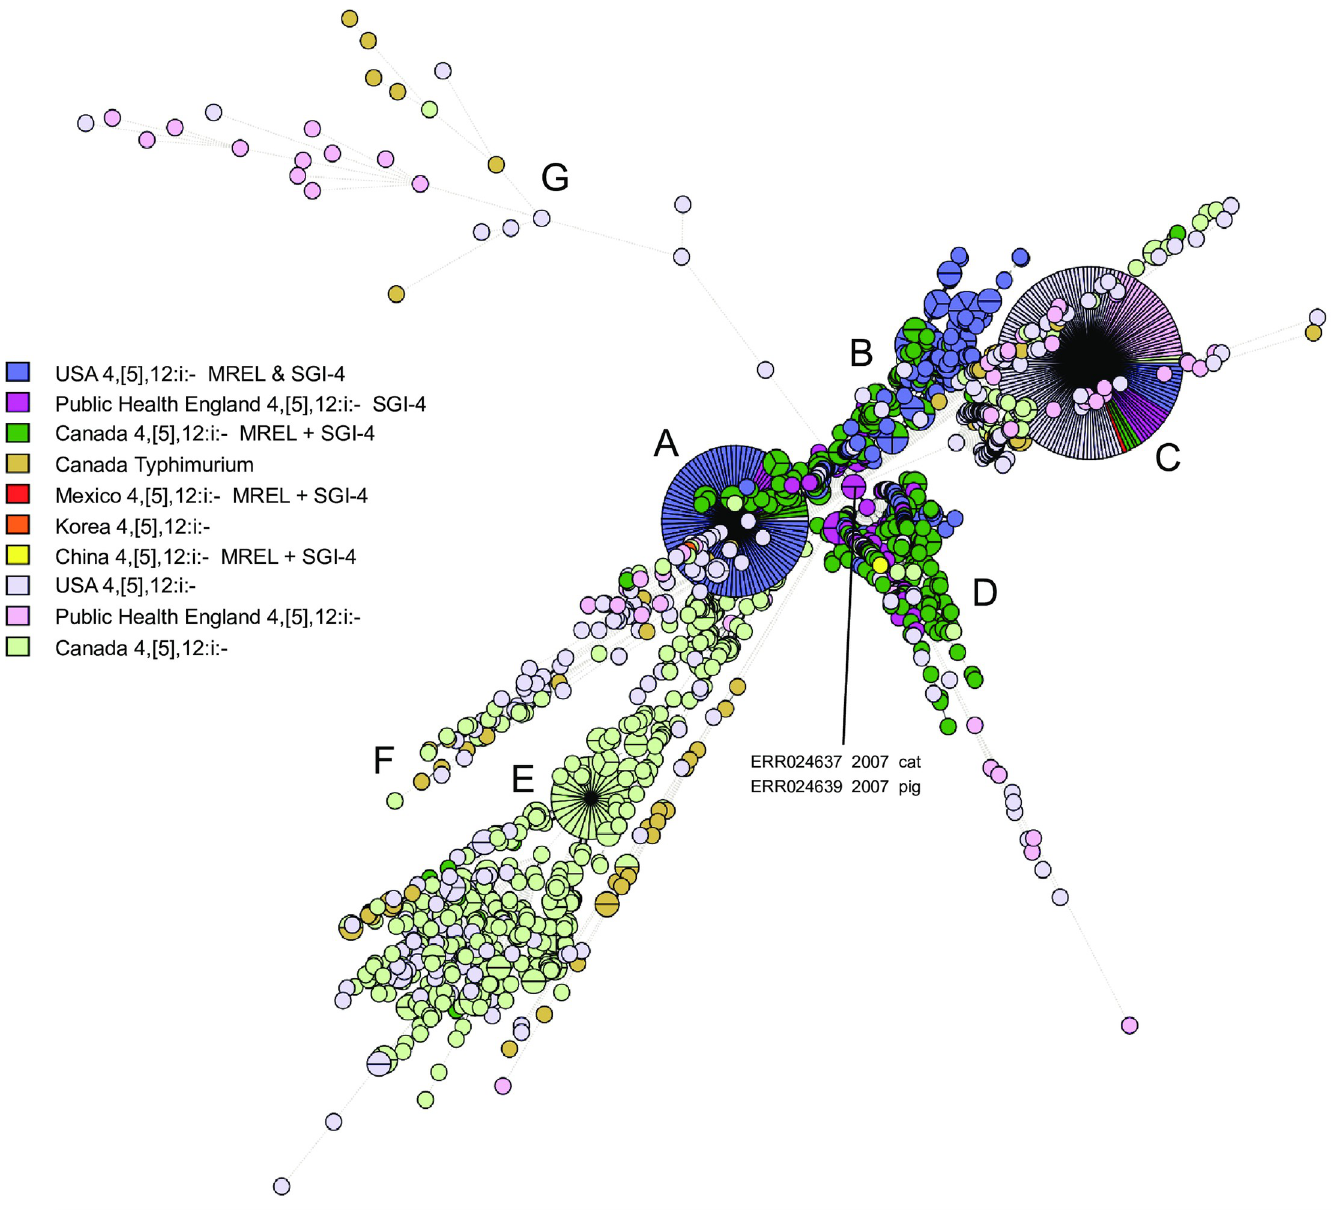
Fig 15. Minimum spanning tree of wgMLST data showing the distribution of SGI-4/MREL-containing isolates within the global Salmonella 4,[5],12:i:- population analyzed. The MST was prepared as for Fig 5. The presence of SGI-4 and/or the MREL for the US and Public Health England isolates was inferred from the metadata in the respective published papers [14,15]. For the US data the presence of the MREL was indicated by the detection of potential RR1, RR2, and RR3 sequences (S1 Table in [14]). The presence of SGI-4 was not indicated. The PHE data clearly indicated the presence of SGI-4 (labelled SGI-3, see Technical Appendix 2, Fig 3 in